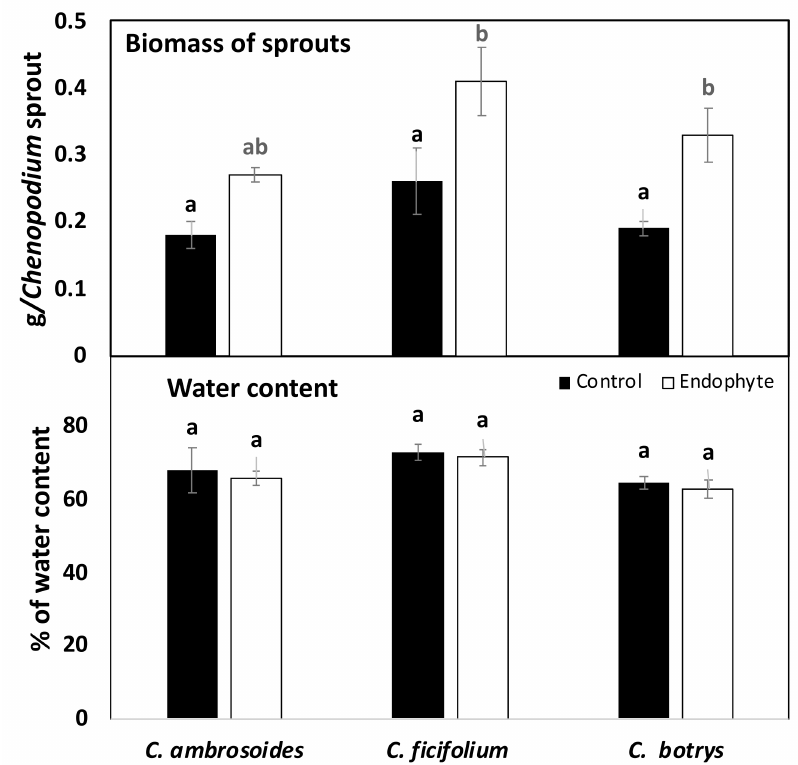
Figure 2. Biomass and water content of control and endophytic bacterial-treated Chenopodium ambrosoides, Chenopodium ficifolium, and Chenopodium botrys sprouts. Data are represented by the means of at least 3 replicates, and error bars represent standard deviations. Different small letters above bars indicate significant differences between means at p <